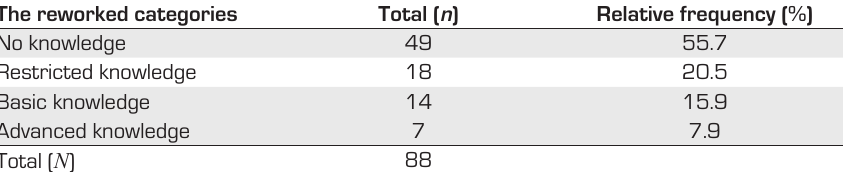
TABLE 4: The reworked